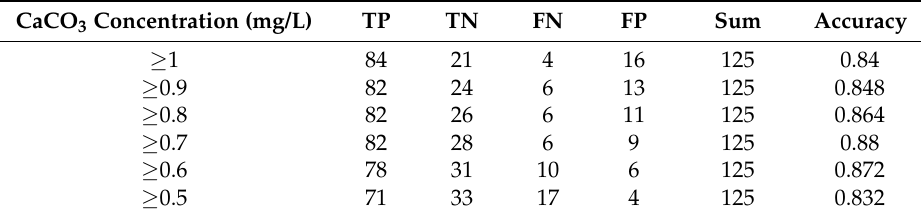
Table 6. Confusion matrices of Landsat-derived calcite precipitation with in situ measurements at Feldberg Lake District.